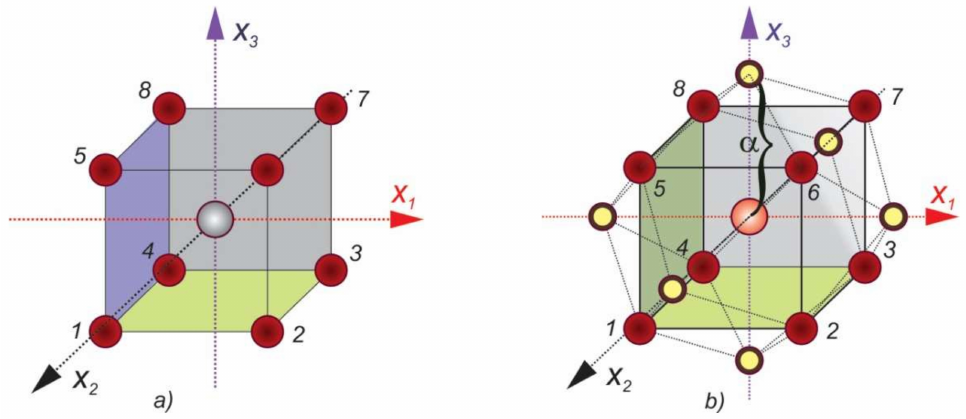
Figure 1. Arrangement of experimental points in 2 k space: ( a ) k = 3; ( b ) k = 3, alpha =